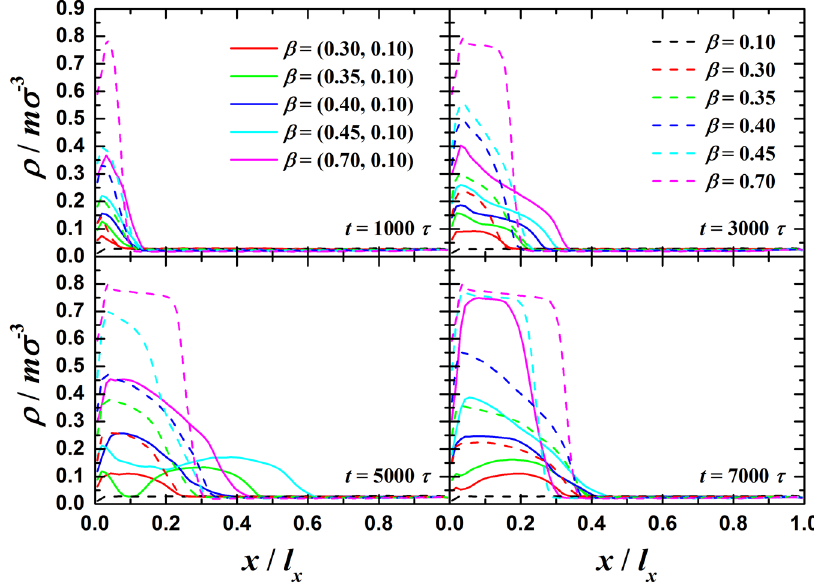
Figure 3. Transient profiles of the averaged density ( ρ ) in y-z plane at different times in the condensation